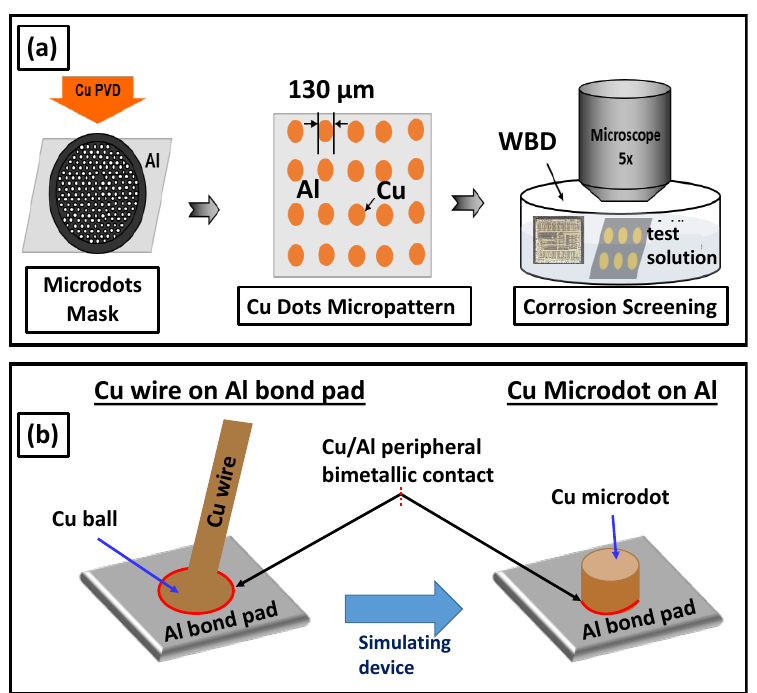
Figure 1. ( a ) Schematic representation of the immersion micropattern corrosion screening metrology and ( b ) micropattern sample peripheral bimetallic contact created to simulate the effect of Cu wire on the Al bond pad.